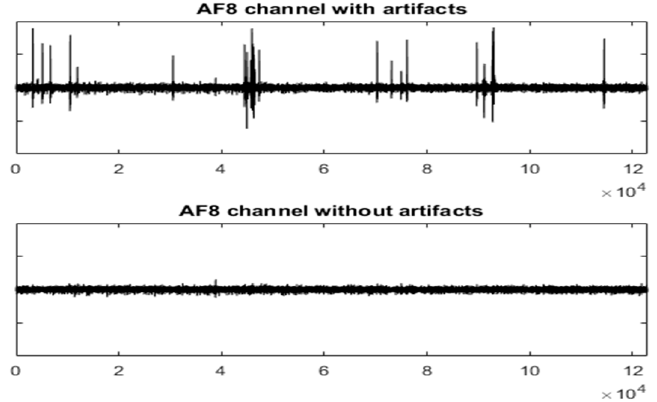
Figure 8. The AF8 channel of AEEG with and without artefacts. The X axes show the samples.